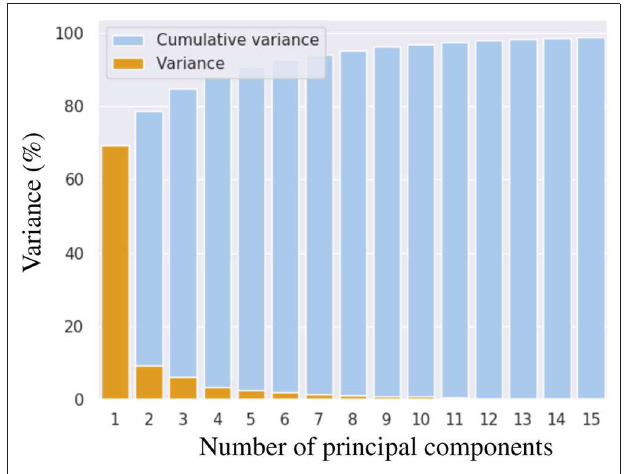
FIGURE 4 | Cumulative variance in shape that is explained when increasing number of principal components are used for representing left ventricular geometry.